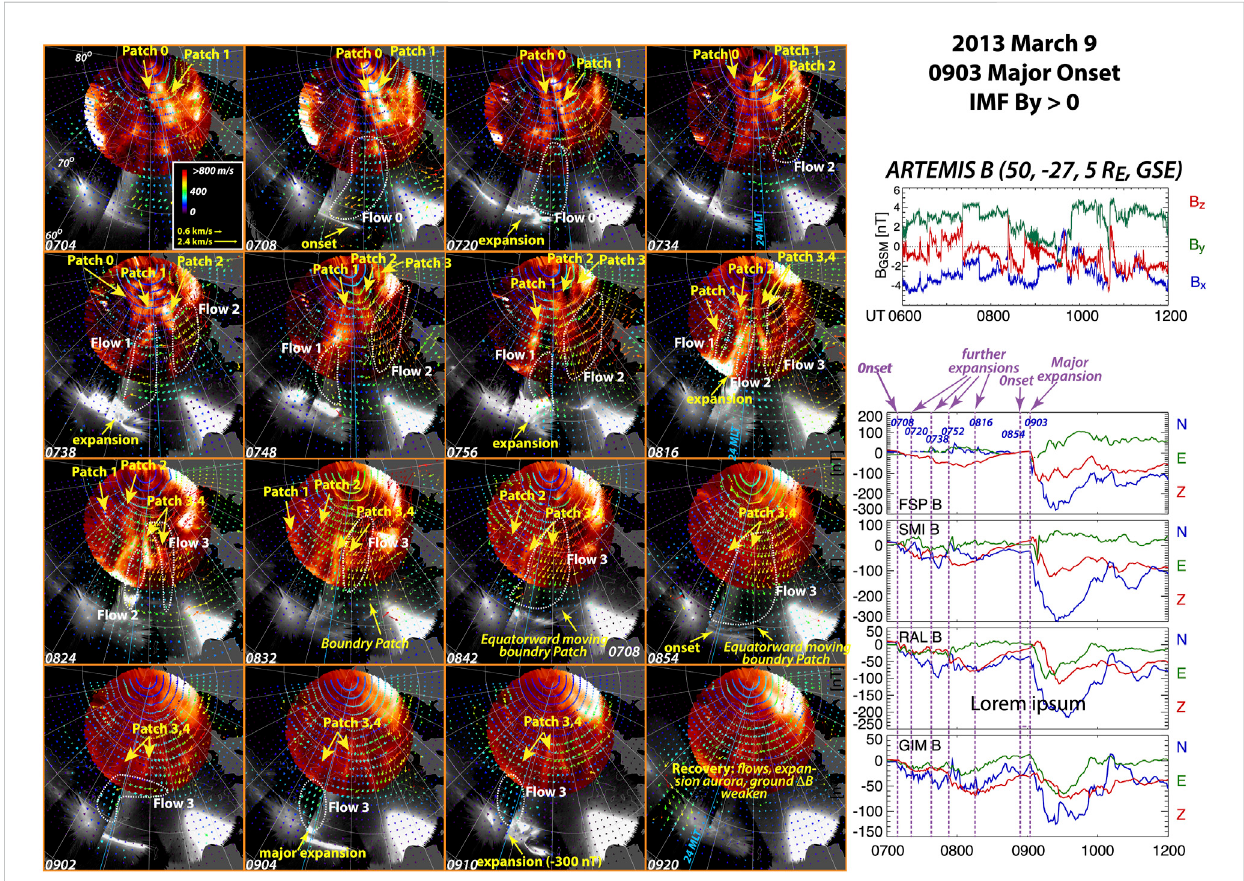
FIGURE 1 Selected mosaics of images for 0704 – 0920 UT on 9 March 2013 from theREGO 630 nm ASI at Resolute Bay (83 ° magnetic latitude) and thelower- latitude THEMIS while light ASIs cover North America. Supplementary Movie S1 shows a movie of the mosaics every 2 min over the full-time interval of interest. Overlaid onthemosaics aretwo-dimensional fl owvectorsobtained from allavailableSuperDARN radarechoesas describedinthetext. TheIMF as measured by the closest available monitor, ARTEMIS B, and ground magnetometer measurements in the vicinity of the auroral disturbance are shown along the right side of the fi